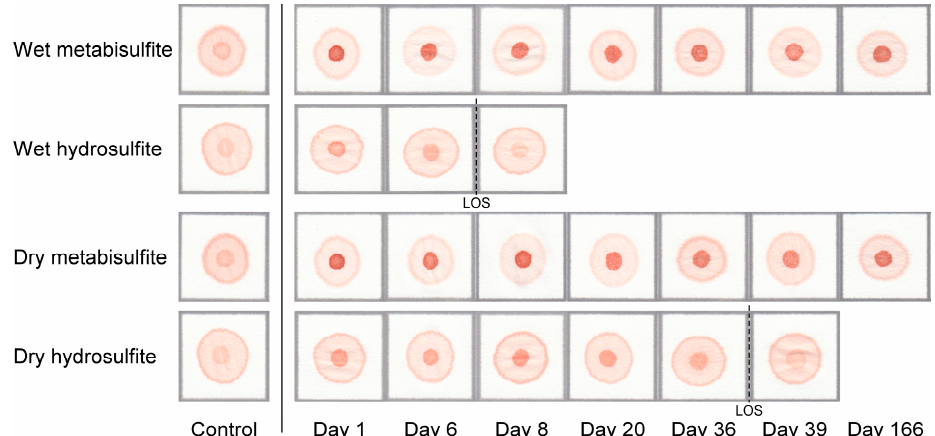
Figure 3. Representative images of blood stains demonstrating the reagent stability of the metabisulfite (MS) and hydrosulfite (HS) formulations of the paper-based SCA screening test under wet and dry storage conditions. ( left ) Blood stain images for samples with 0% HbS (control) produced by the MS and HS versions of the test using freshly prepared reagents. ( right ) Blood stain images for samples with 20% HbS (limit of detection of HS version of test) produced by the MS and HS versions of the test using reagents stored under wet (MS powder mixed with aqueous buffer components before storage) or dry (MS powder stored separately from aqueous buffer components) conditions. The limit of stability (LOS)—i.e., the maximum amount of time reagents can be stored before the difference in pattern between samples with 0% HbS and samples with HbS concentrations greater than, or equal to, the limit of detection of tests performed using fresh reagents becomes statistically insignificant—is indicated by a dashed line.